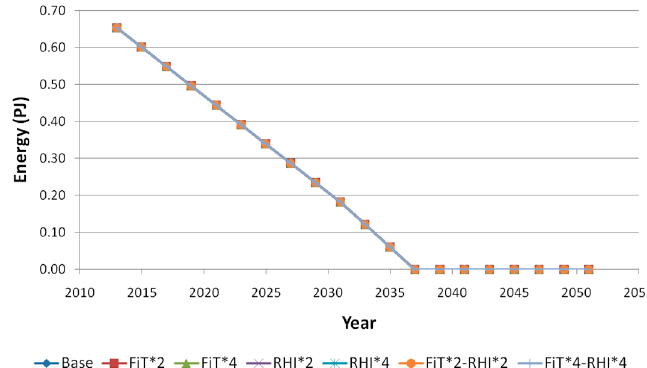
Figure 9. Lowlands farms—fuel consumption.